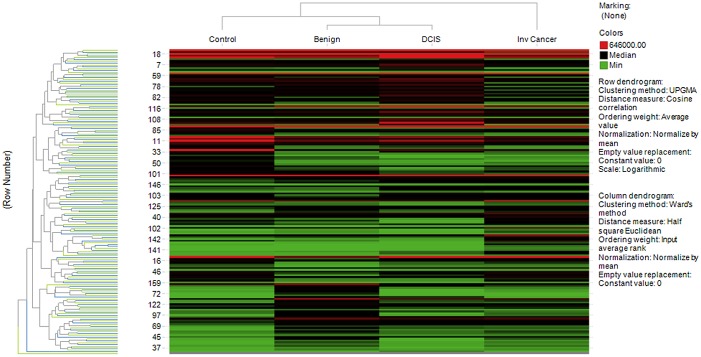
Heat map analysis of urine proteins from BC patients and conrol subjects.Heat map and dendogram of the raw data of urinary proteins identified up or down expression of urine proteins from different stages of BC patients and normal health control subjects.